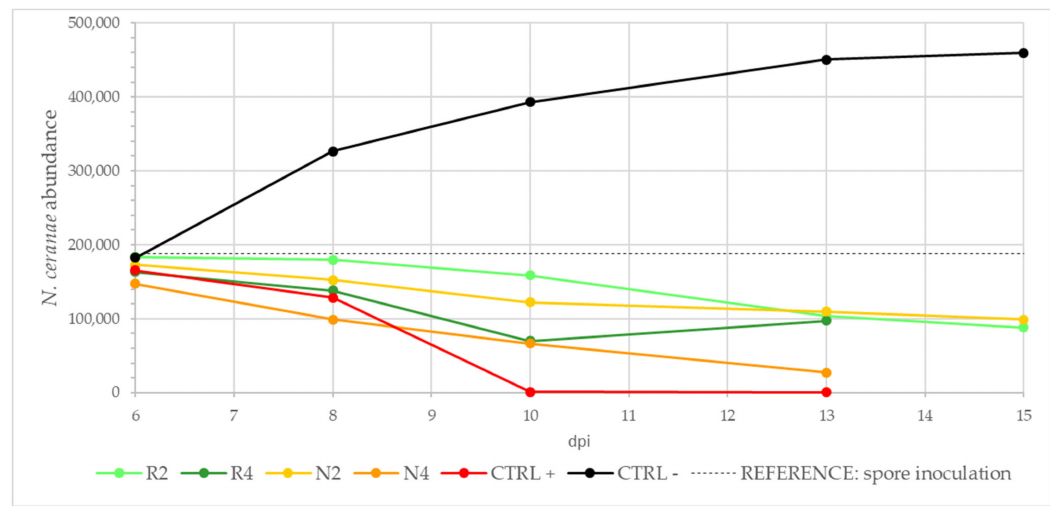
Figure 5. Variation in the N. ceranae copies across the timeline in the different treated groups (R2, R4, N2, N4), CTRL+ and CTRL −